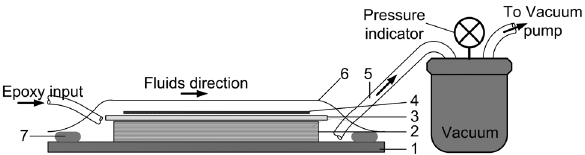
Figure 1 Schematic layout of VARTM: (1) bronze plate, (2) laminate fiber, (3) release films, (4) breather net, (5) vacuum tube, (6) plastic bag, and (7) sealant